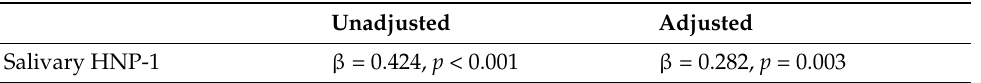
Figure 4. Salivary human- β defensin (hBD)-3 levels in relation to the extent of periodontal destruction (empty circles indicate outliers). No significant differences were found between the groups. Linear regression analyses revealed an association between elevated salivary HNP-1 levels and having an increased number of teeth with PPD ≥ 4 mm (Table 2). Table 2. Unadjusted and adjusted associations between salivary HNP-1 levels and an increased number of teeth with PPD ≥ 4 mm.